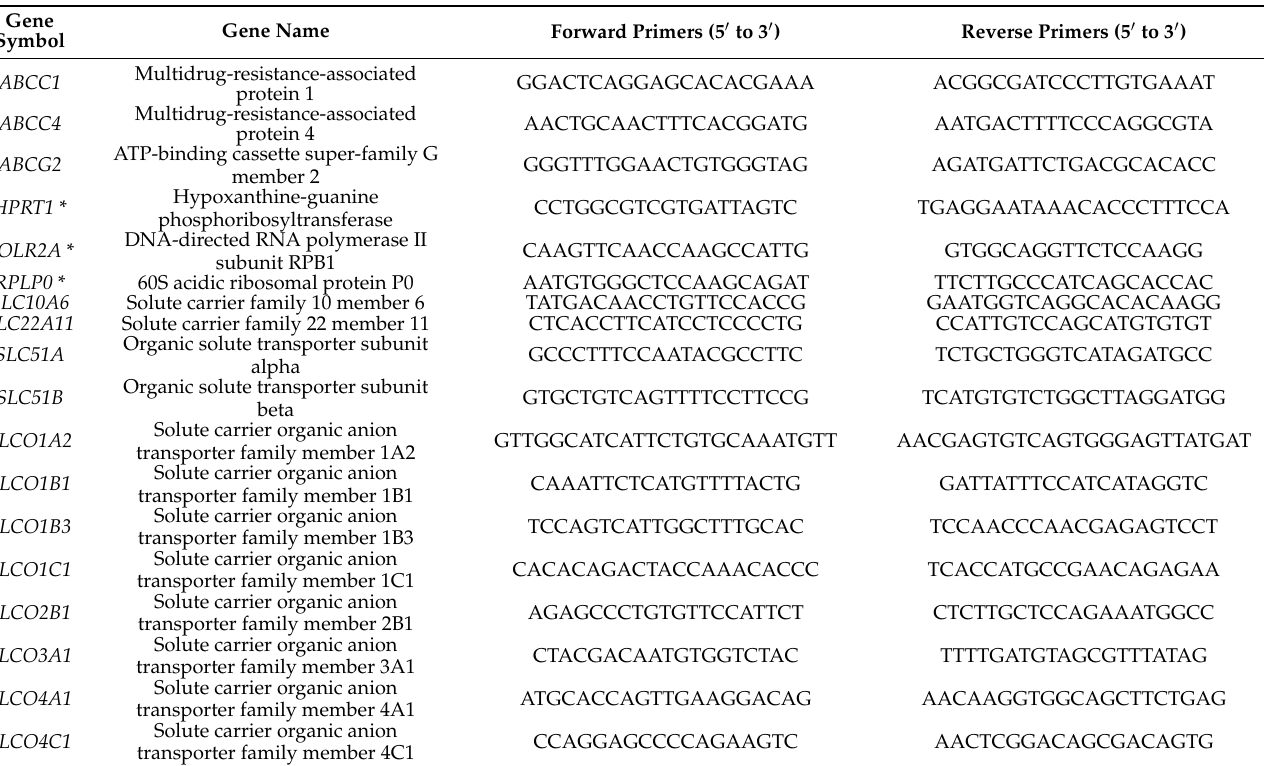
Table 2. Primer sequences for evaluating gene expression using the SYBR Green assay